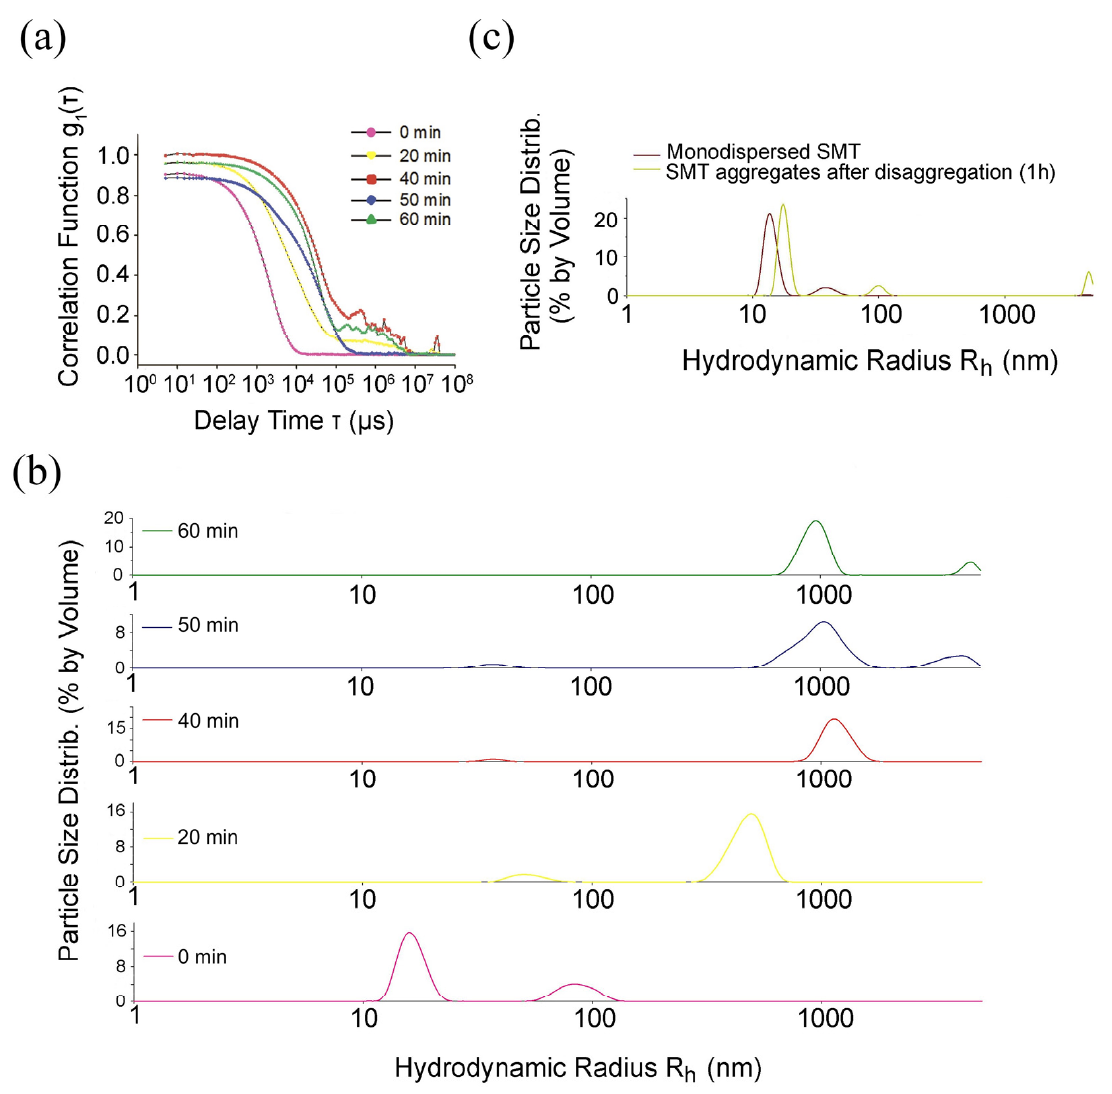
Figure 1. ( a ) Evolution of field autocorrelation functions g 1 ( t ) of light scattered during SMT HMW amyloid aggregate formation (pH 7.0–7.5, T = 25 °C). Aggregation was observed in a solution containing 0.15 M glycine–KOH, pH 7.0–7.5; ( b ) size distributions of SMT HMW particles. Generation of large aggregates and their time-dependent growth are shown; ( c ) distribution of SMT HMW particles after 1 h disaggregation (for clarity, the graph shows monodispersed SMT HMW ). The data reflect the distributions corresponding to certain time points. Three independent experiments were carried out .